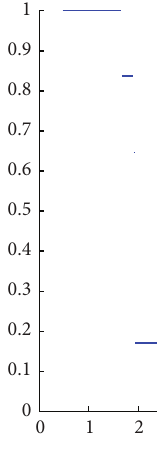
Figure 6: The influence of 𝜎 on algorithm